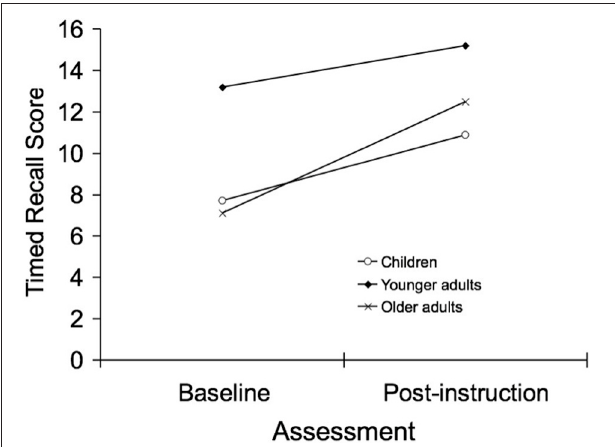
FIGURE 4 | Baseline performance and gains from instruction. Mean performance (Timed Recall Score) at baseline and post-instruction assessment for children, younger adults, and older adults, as predicted from baseline performance and instruction gain.